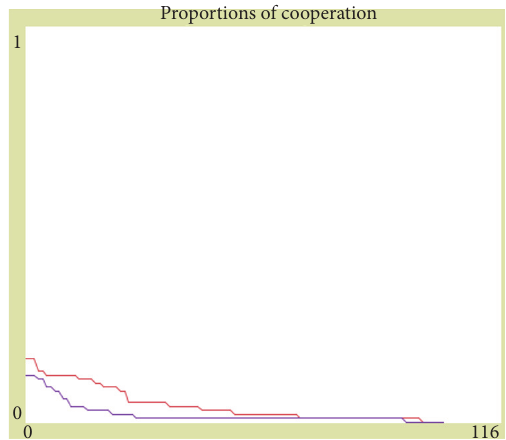
Figure 8: Simulation on knowledge workers’ CWB when working environment is